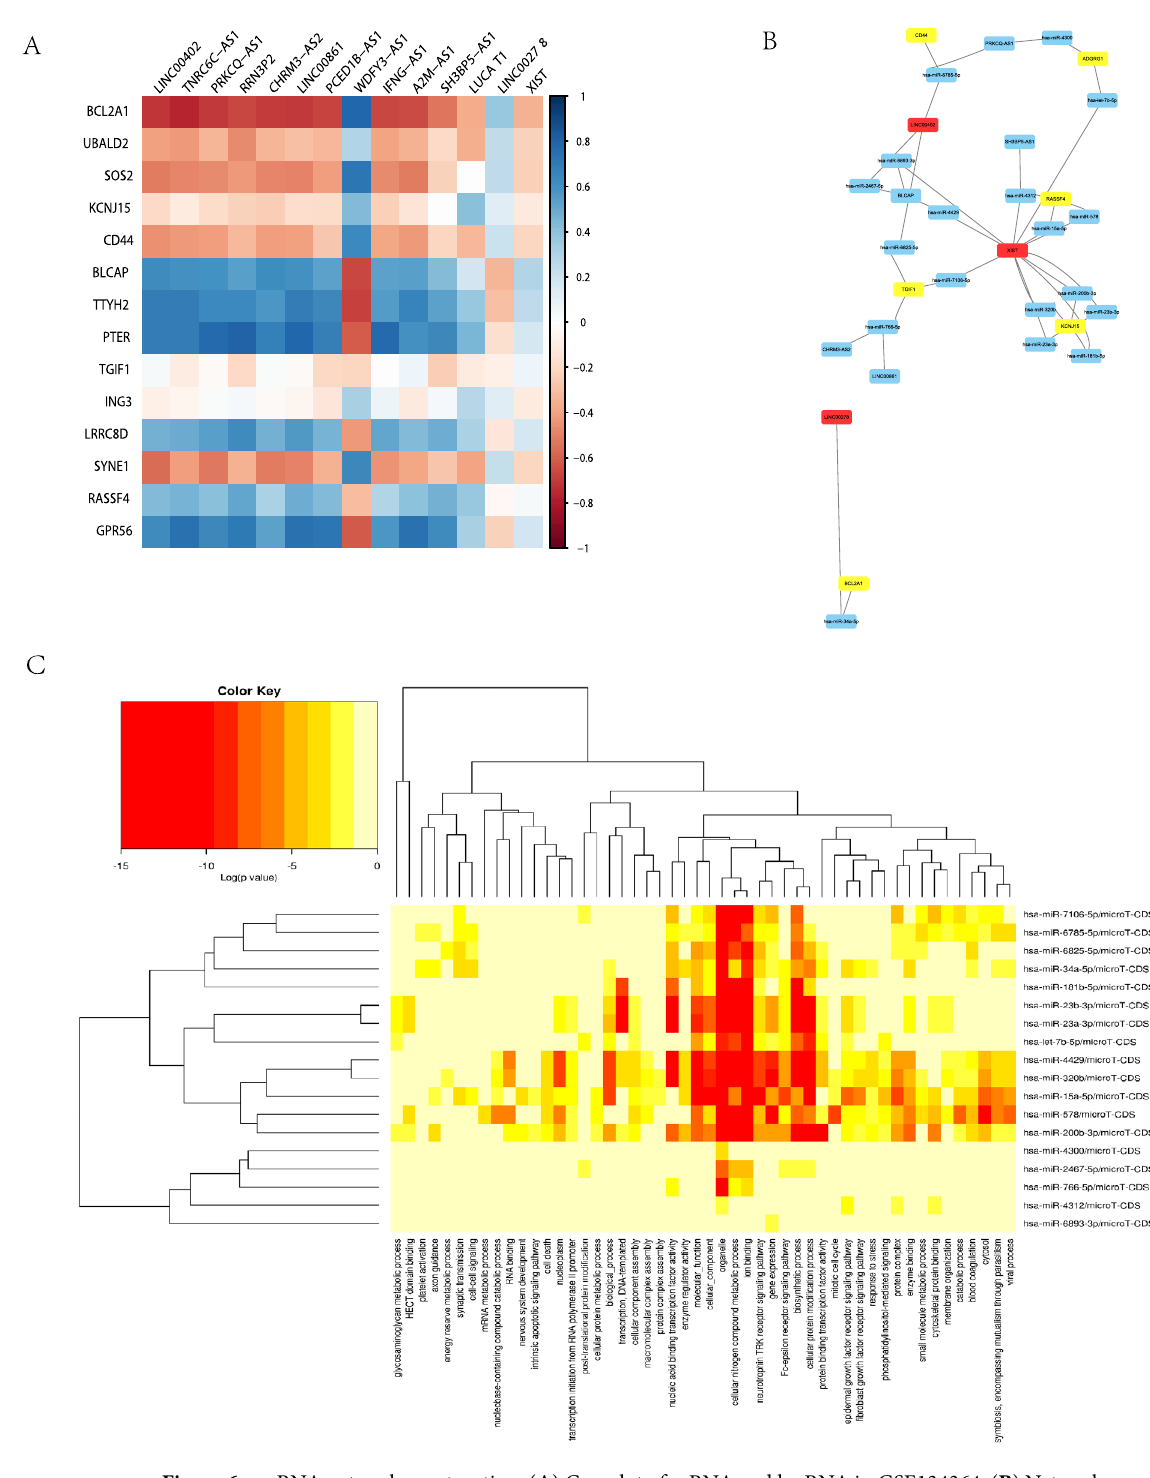
Figure 6. ceRNA network construction. ( A ) Corrplot of mRNA and lncRNA in GSE134364. ( B ) Network generated by Cytoscape of ceRNA. ( C ) Functional enrichment analysis of miRNAs identified using the GO